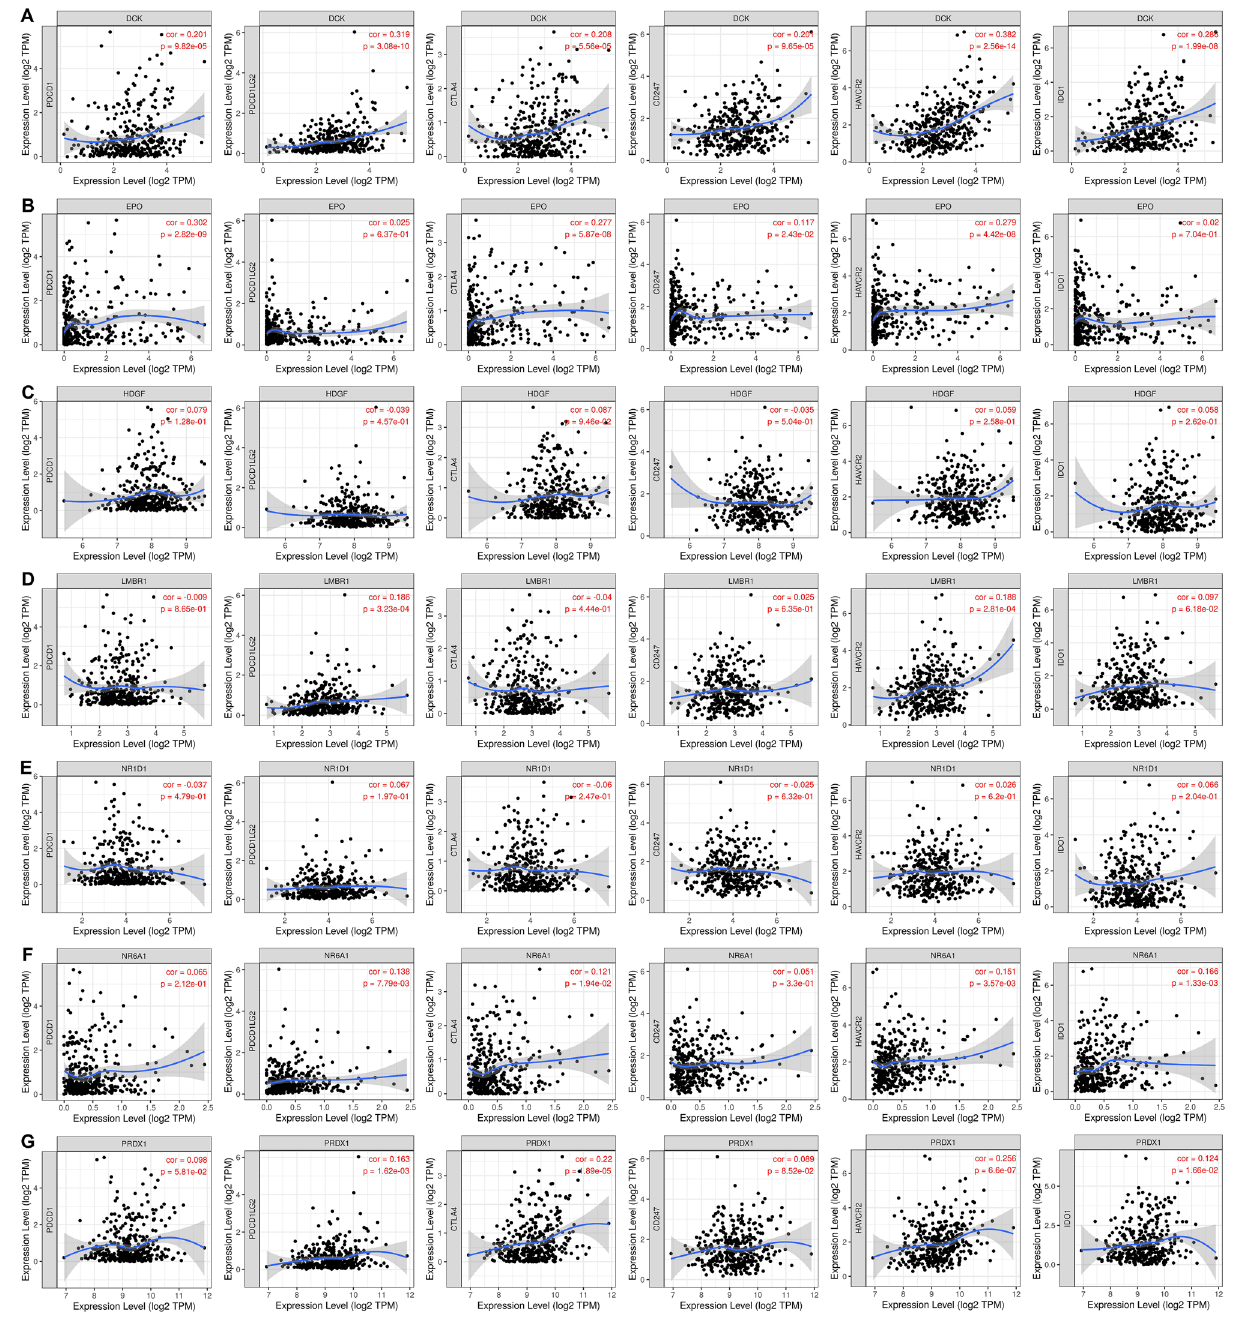
Figure 8. The expression scatterplots of IRGs and another 6 immune checkpoints based on TIMER database